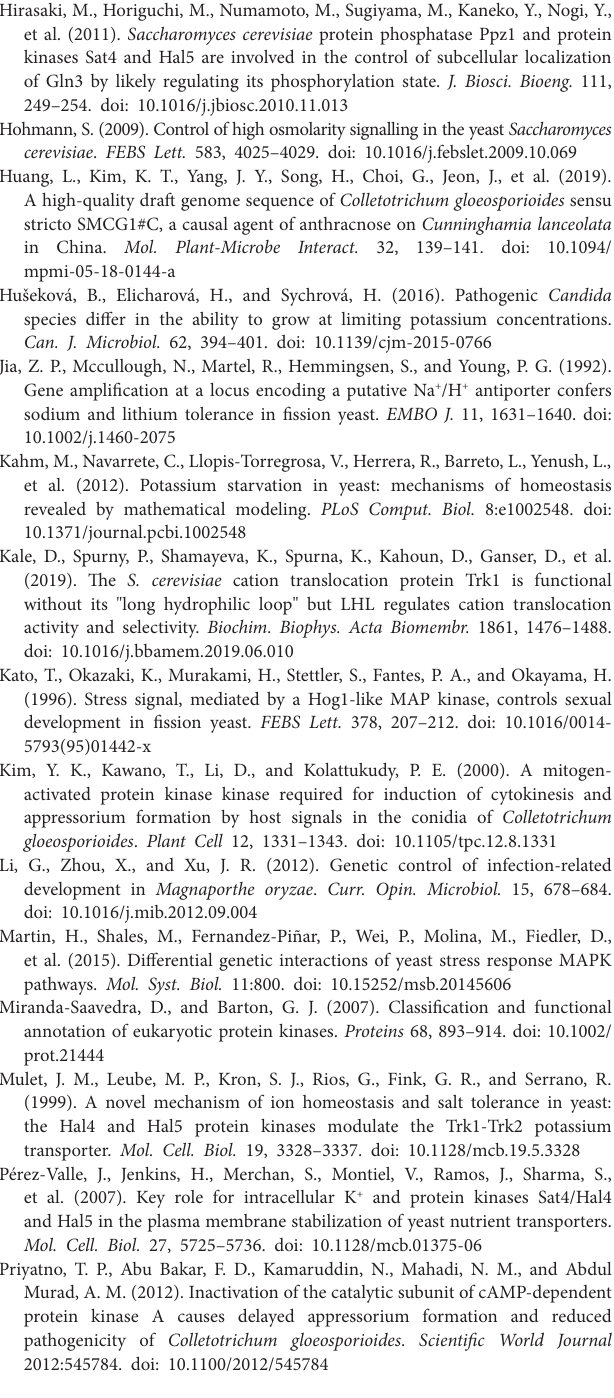
Supplementary Figure S2 | CgSat4 does not directly interact with CgTrk1 and CgHog1. (A) Co-immunoprecipitation (Co-IP) assays or the interaction between CgSat4 and CgTrk1. The CgTRK1 -GFP/ CgSAT4 -S were co-expressed in the wild- type strain. Total proteins isolated from mycelium of transformants and proteins eluted from the GFP-Trap-A beads were analyzed by Western blotting with anti- GFP and anti-S antibodies. (B) Yeast two hybrid assay for the interaction between CgSat4 and CgTrk1. The AD and BD plasmids were co-transformed into yeast AH109, and transformants were plated on SD-Leu-Trp for 3 d and on selective